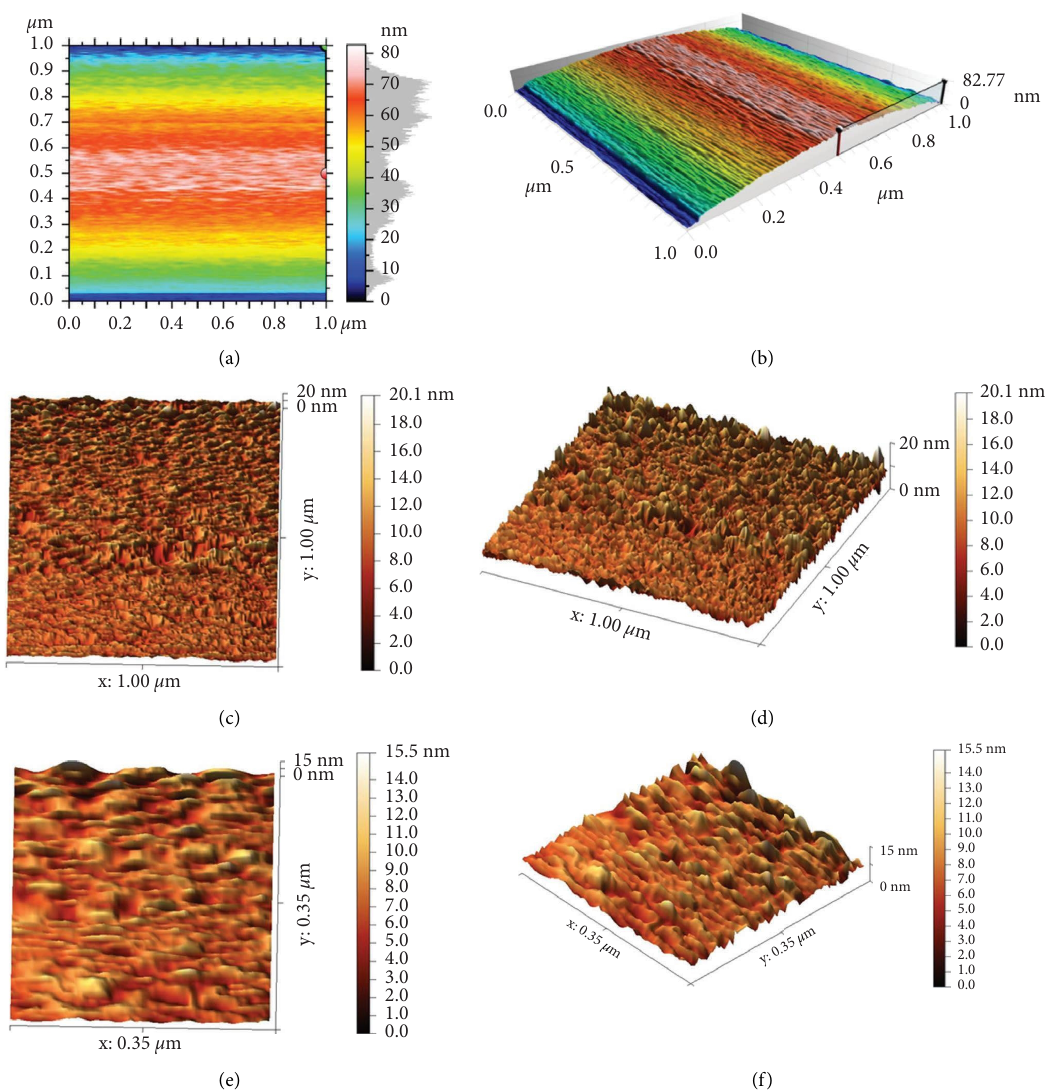
Figure 3: AFM topographical micrograph for the prepared CHX-HMP nanoparticles: (a) 2D at 1 μ m, (b–d) 3D at 1 μ m, and (e, f) at 0.35 μ